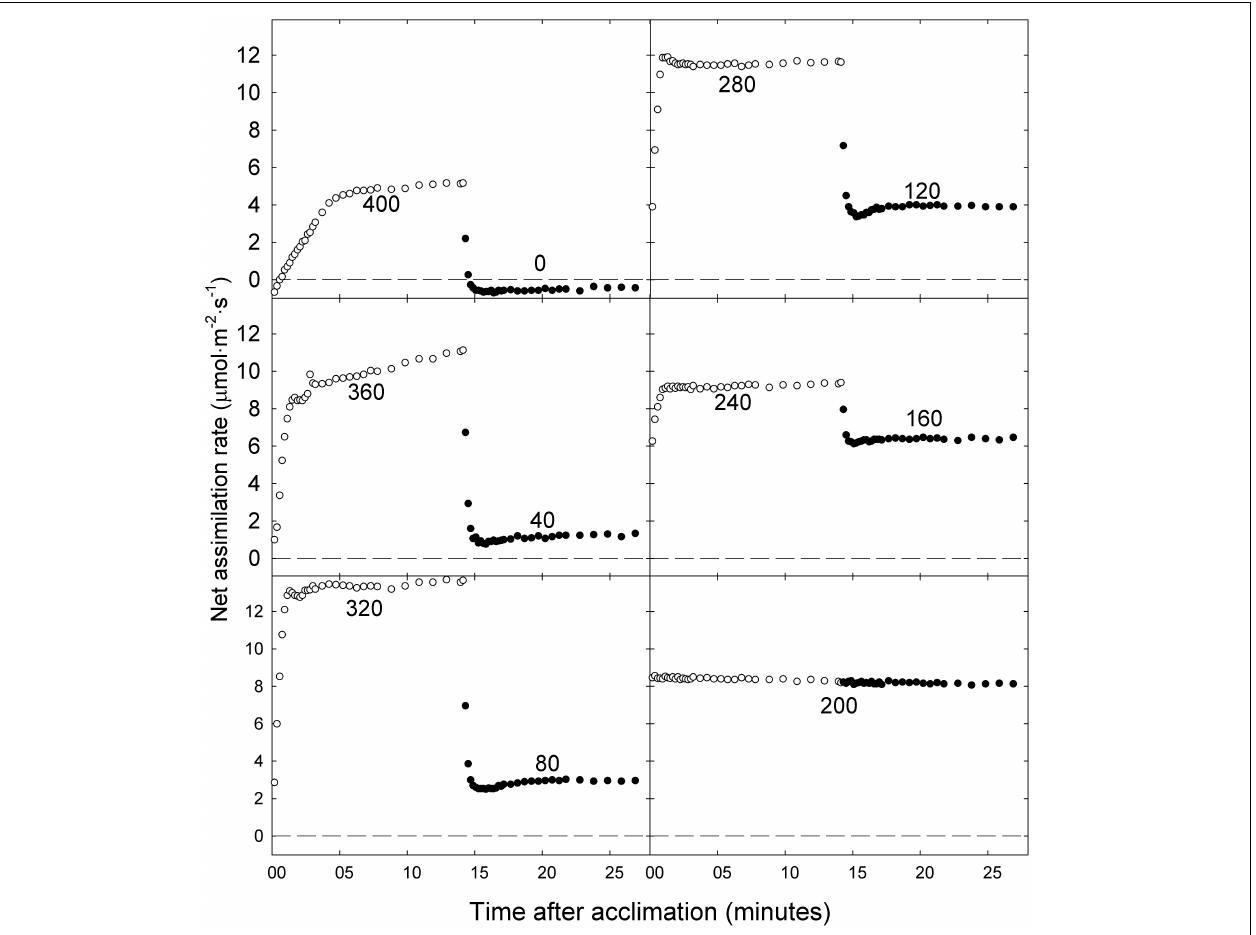
FIGURE 4 | Net photosynthetic rate of ‘Green Salad Bowl’ lettuce ( Lactuca sativa ) during a 15 min high photosynthetic photon flux density (PPFD) period followed by a 15 min low PPFD period (400/0, 360/40, 320/80, 280/120, 240/160, and 200/200 µ mol · m − 2 · s − 1 ). Open circles represent high PPFD, and closed circles low PPFD. Values in each graph indicate the